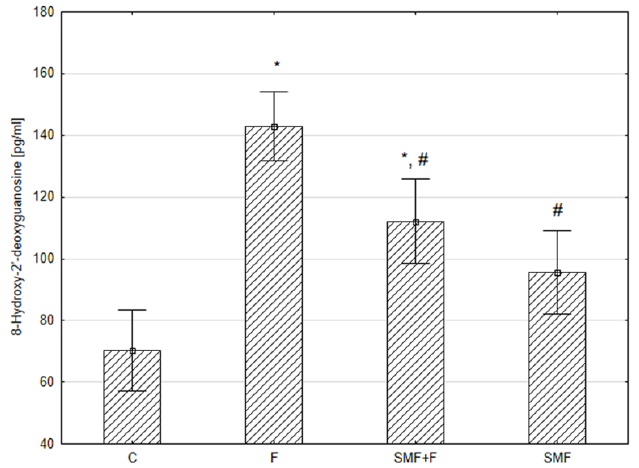
Figure 3. The DNA/RNA oxidative damage marker concentration in the control cells (C), F − -treated cells (F), cells that had been exposed to a static magnetic field (SMF) and cells that had simultaneously been exposed to a static magnetic field and F − (SMF + F). The results are presented as the mean ± SD; statistical significance: * p < 0.05 vs. C; # p < 0.05 vs. F.